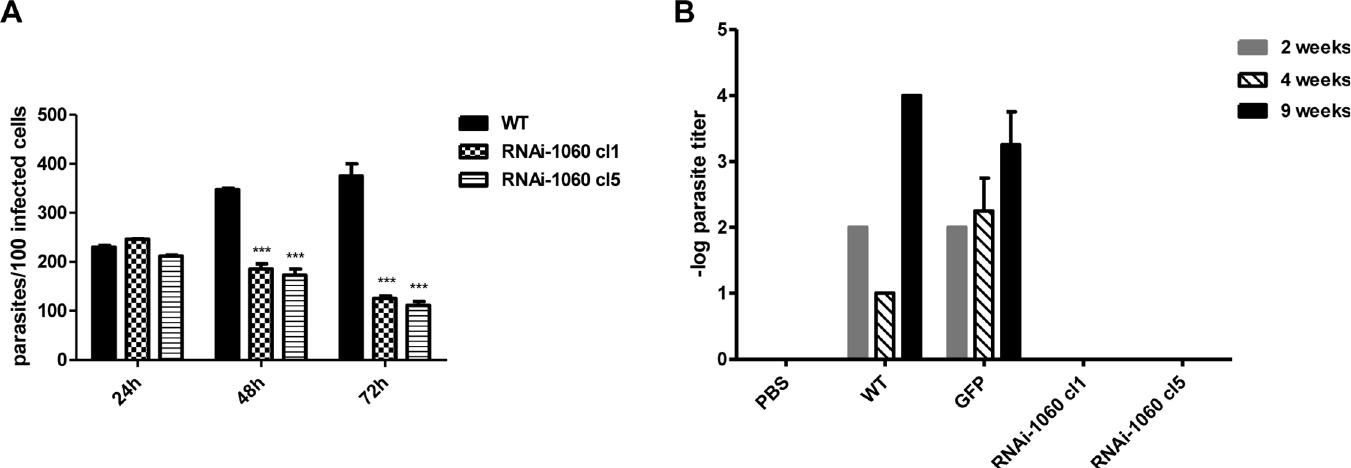
Fig 7. Infection of mouse macrophages and BALB/c mice footpads with WT L . braziliensis and RNAi-1060 cell lines. (A) Intraperitoneal macrophages from BALB/c mice were incubated for 24 hours at 34°C with stationary phase promastigotes from WT L . braziliensis cultures and the two cloned cell lines RNAi-Ama1060 cl1 and cl5 at a ratio of 10: 1 parasites/cell. After washing non-internalized promastigotes macrophages were incubated for 24, 48 or 72 hours before the cells were stained with DAPI and the numbers of intracellular amastigotes, visualized by fluorescence microscopy, were determined. (B) BALB/c mice were infected in the footpads with 10 7 stationary phase promastigotes from WT L . braziliensis , L . braziliensis transfected with the pIR1PHLEO vector containing GFP, and two cloned cell lines expressing δ -amastin siRNA, RNAi-1060cl1 and cl5. Two, four and nine weeks after infection, parasitism was evaluated by the limiting dilution